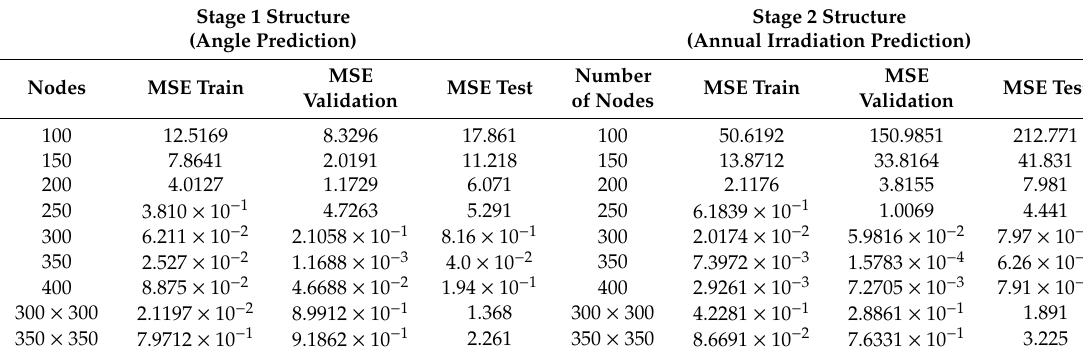
Table 3. The hidden layers number of neurons vs. best-obtained